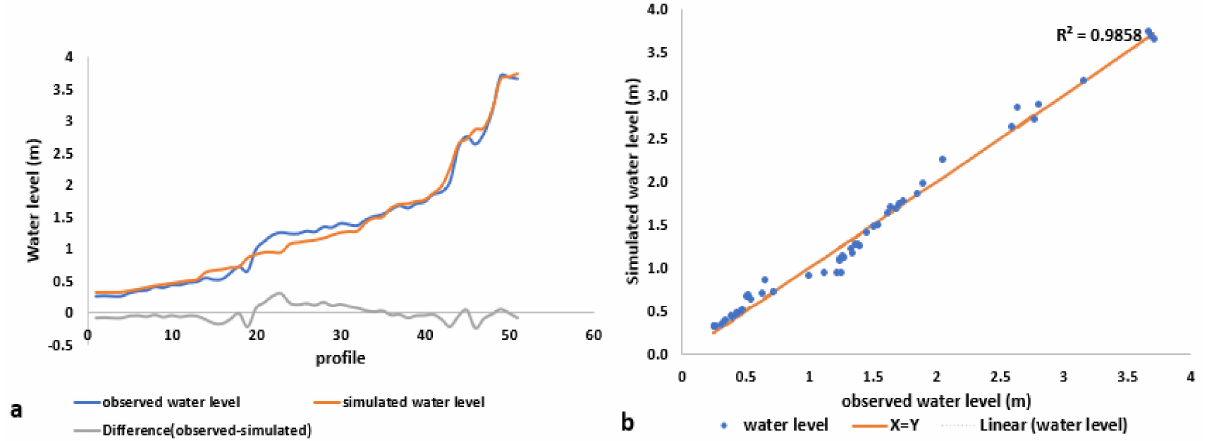
Figure 3. Simulated and observed water levels in Drammenselva during the flood in 2007.